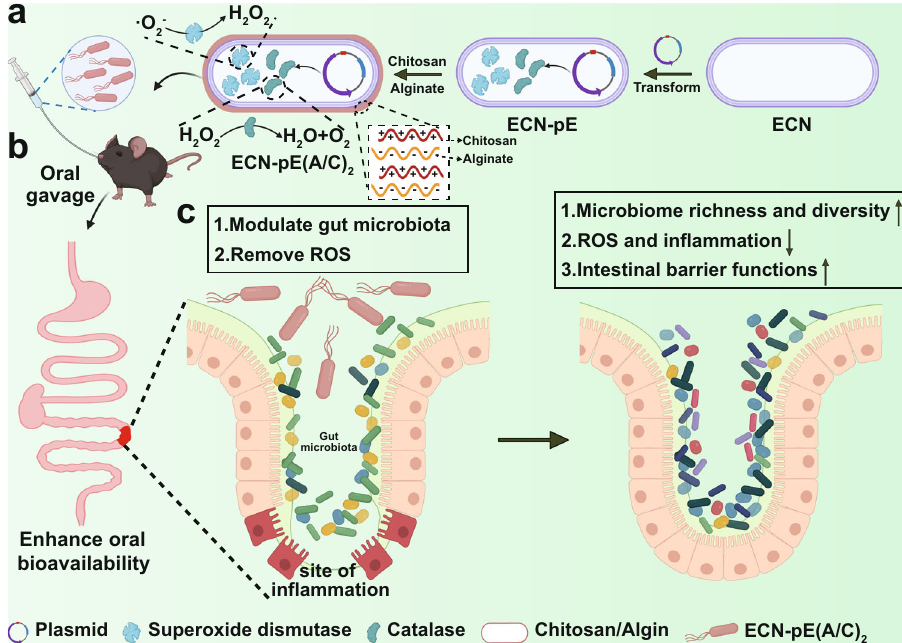
Fig. 1 Engineered probiotics for IBD treatment. a ECN was genetically engineered to produce CAT and SOD, which can scavenge ROS ef fi ciently. Then, the engineered ECN was encapsulated by chitosan and sodium alginate through the layer-by-layer strategy (ECN-pE(C/A) 2 ). ECN Escherichia coli Nissle 1917; ECN-pE, ECN(pET28a-T5-CAT-SOD). b ECN-pE(C/A) 2 was orally delivered to the mice, and its bioavailability within the GI tract was signi fi cantly elevated with chitosan/sodium alginate coating. c ECN-pE(C/A) 2 exerts a prominent palliative effect to relieve in fl ammatory bowel disease by eliminating ROS and regulating the intestinal fl